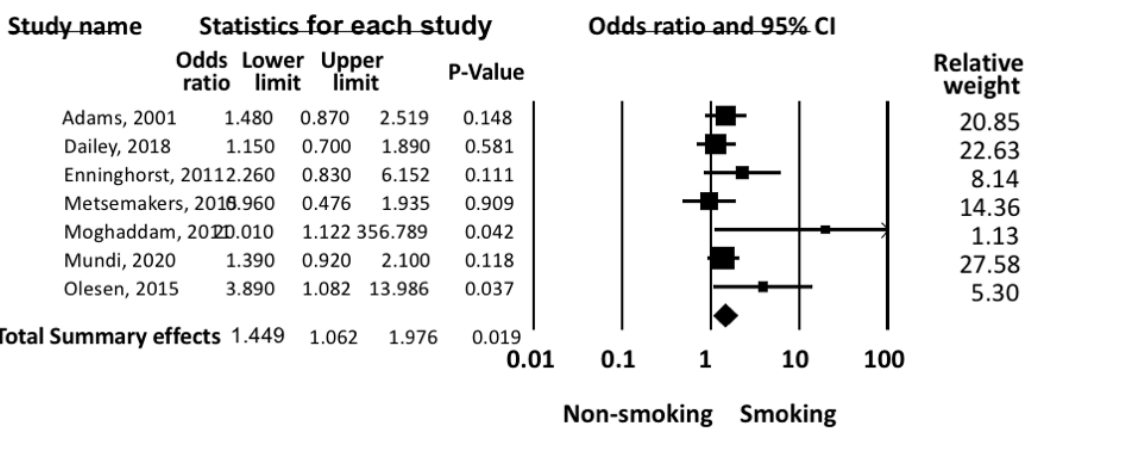
Figure 2. Meta Analysis for non-union.